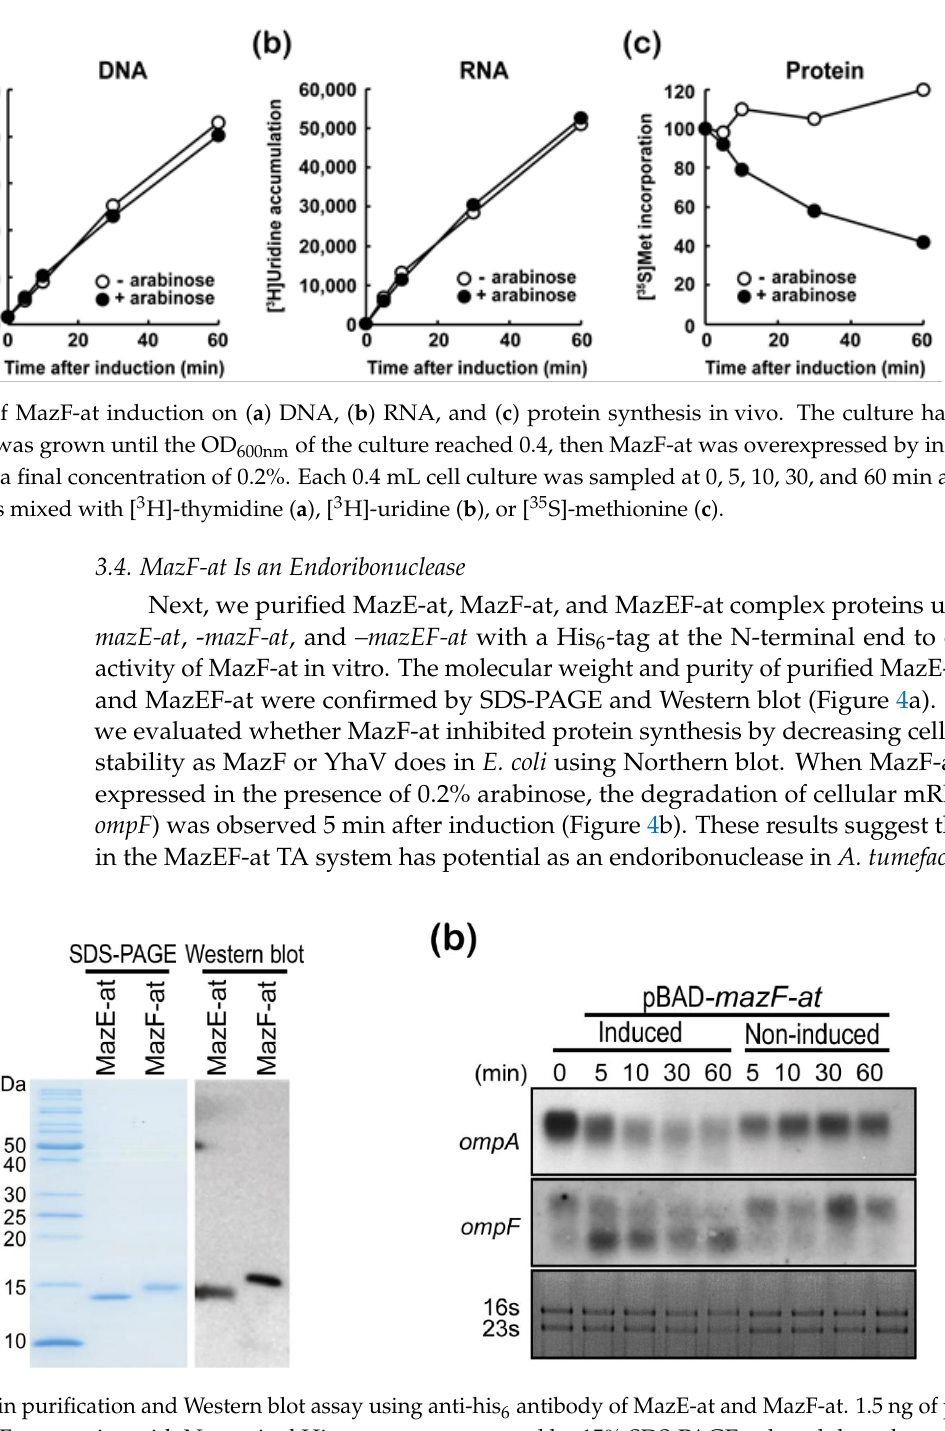
Figure 5. Endoribonuclease activity assay of ( a ) MazF-at, ( b ) MazEF-at complex, and ( c ) MazF-ec on MS2 phage RNA. 0.5 µM of MazF-at, MazEF-at, or MazF-ec protein was incubated with 0.8 µg/µL MS2 phage RNA, and the reaction was loaded on 1.5% agarose gel. The arrowheads indicate the full-length of MS2 phage RNA. 3.5. Characterization of Purified MazE-at and MazF-at Proteins To investigate the secondary structure of MazE-at and MazF-at, we used far-UV cir- cular dichroism (CD) with 0.25 mg/mL of purified proteins. The CD spectrum of MazE-at showed two negative peaks at approximately 208 and 222 nm that consist of α-helices (30.9%), β-sheets (31.5%), turns (19.7%), and random coils (18.0%) (Figure 6a). Moreover, MazF-at also has two negative peaks at approximately 208 and 222 nm, which consist of α-helices (28.9%), β-sheets (32.1%), turns (19.6%), and random coils (21.9%) (Figure 6b). The components of the secondary structures were calculated through CDNN [21]. These results suggest that the two proteins have similar secondary structure compositions. Nor- mally, the antitoxin of type II TA systems has the ability to block the activity of its cognate toxins by forming a TA complex through protein-protein interactions. To confirm the in vitro interaction of the antitoxin MazE-at with MazF-at, we performed a pull-down assay using GST-MazE-at fusion protein. When MazF-at was incubated with GST or GST-MazE- at immobilized beads, GST-MazE-at only showed the band of MazF-at with His 6 -tag at